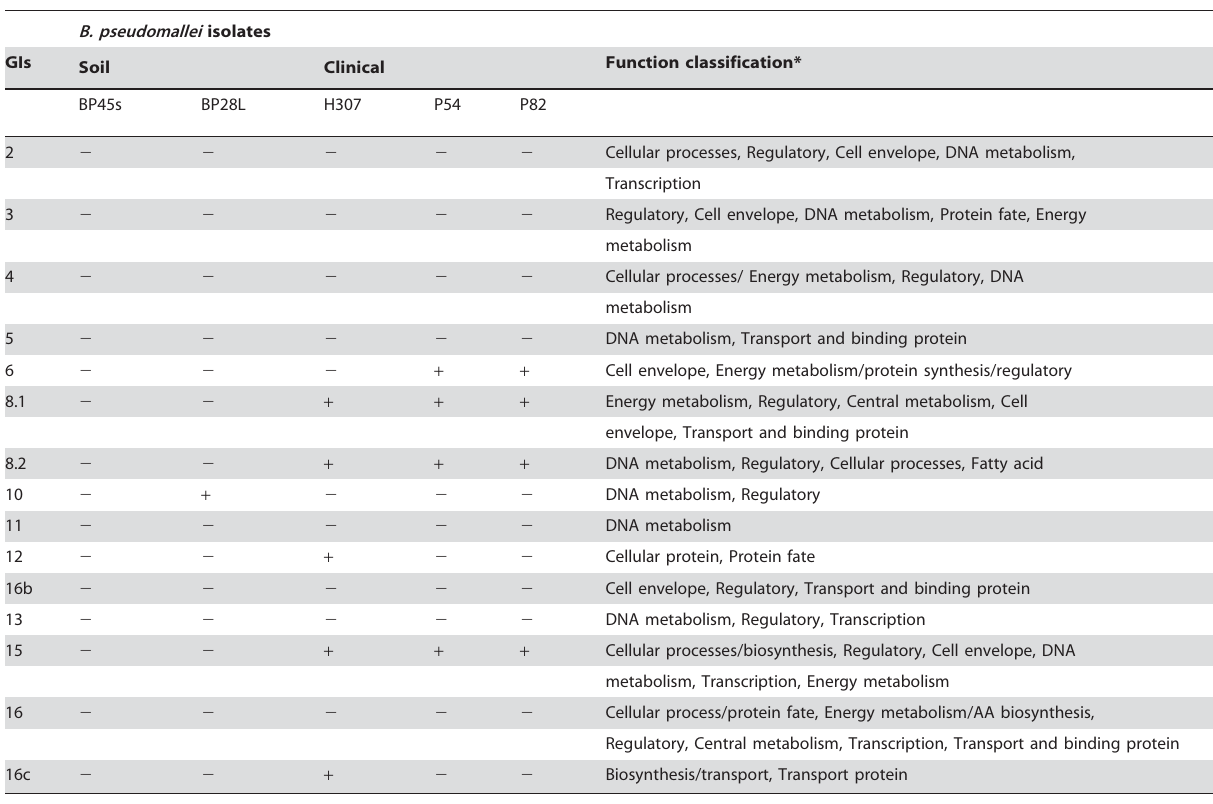
Table 2. The GIs determined by DNA microarrays and their functional classification.